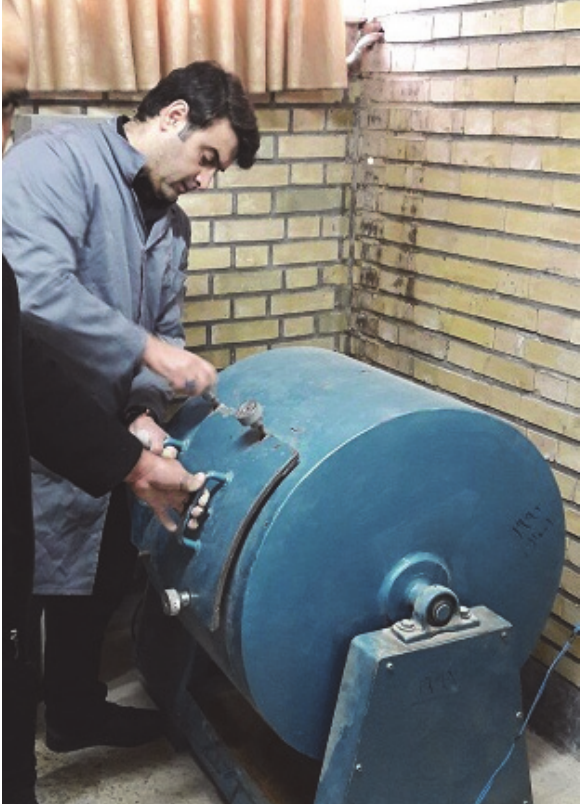
Figure 1: Abrasion strength test machine